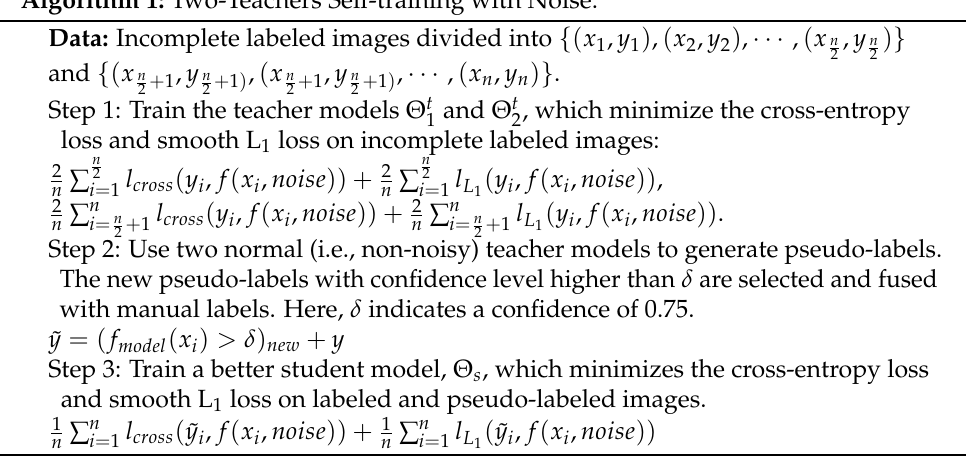
Figure 9. Illustration of the Two-Teachers Self-training with Noise model: Line 1 trains noisy data set 1 and obtains teacher model 1, which is then used to predict the noiseless data set 2. Line 2 trains noisy data set 2 and obtains teacher model 2, which is then used to predict noiseless data set 1. Finally, the output of the two is fused with the original labels and used to train the student model. Algorithm 1: Two-Teachers Self-training with